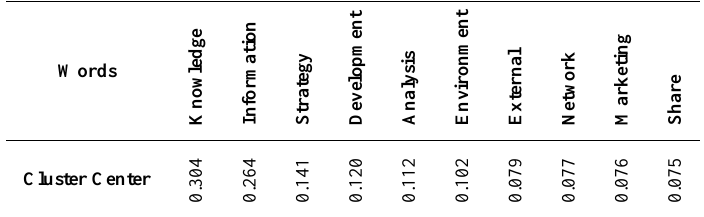
Table 4. Words and final centers of third